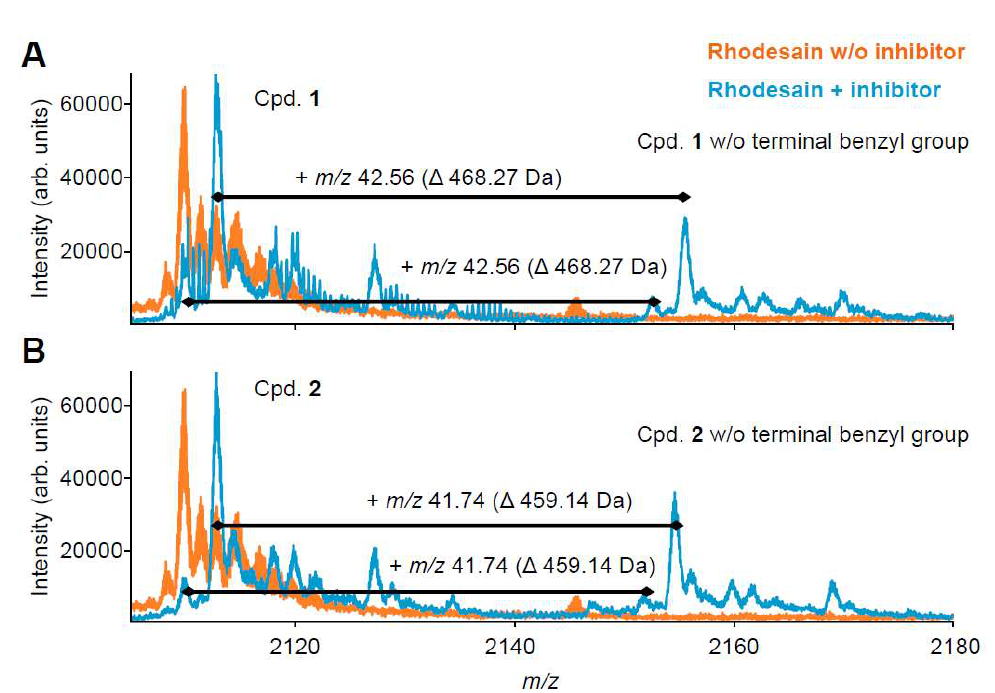
Figure 5. ESI–MS (electrospray ionization) mass spectra (MS) of rhodesain ([M + 11 H] 11 + at m / z 2109.9 ± 20 ppm) in the absence (orange) or presence (blue) of compounds 1 ( A ) and 2 ( B ). The addition of compounds 1 and 2 resulted in mass shifts of ( A ) m / z 42.56 (corresponding to 468.27 Da) and ( B ) m / z 41.74 (corresponding to 459.14 Da), in both cases indicating the formation of an adduct between rhodesain and the hydrolysis product (i.e., the acid) of the respective compound.